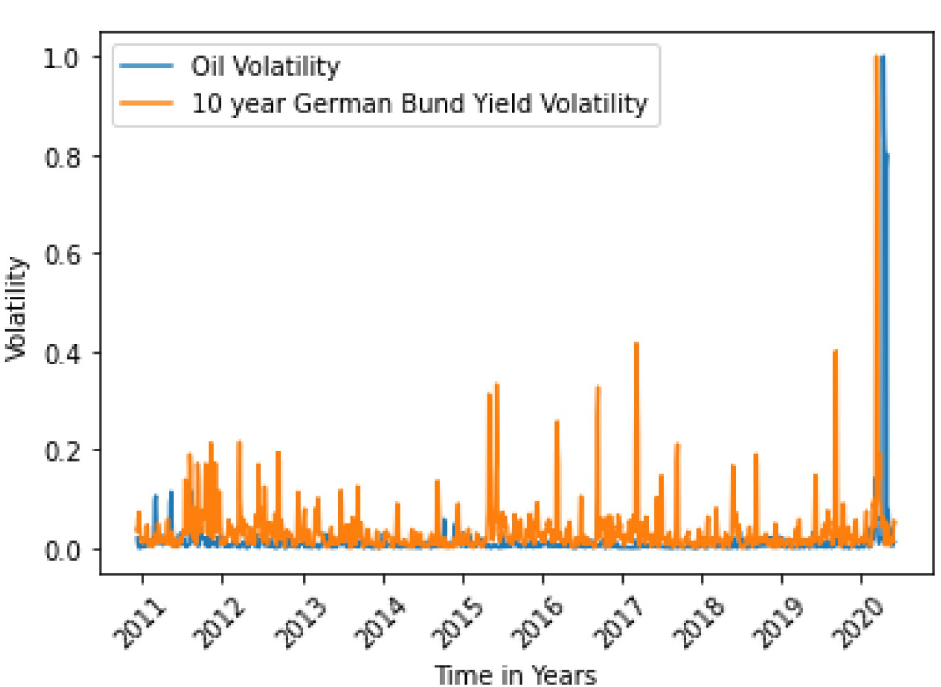
Fig 12. German 10 yr Bund Yield variance does not Granger cause oil variance. Here, the correlation between two data is 0.0433.